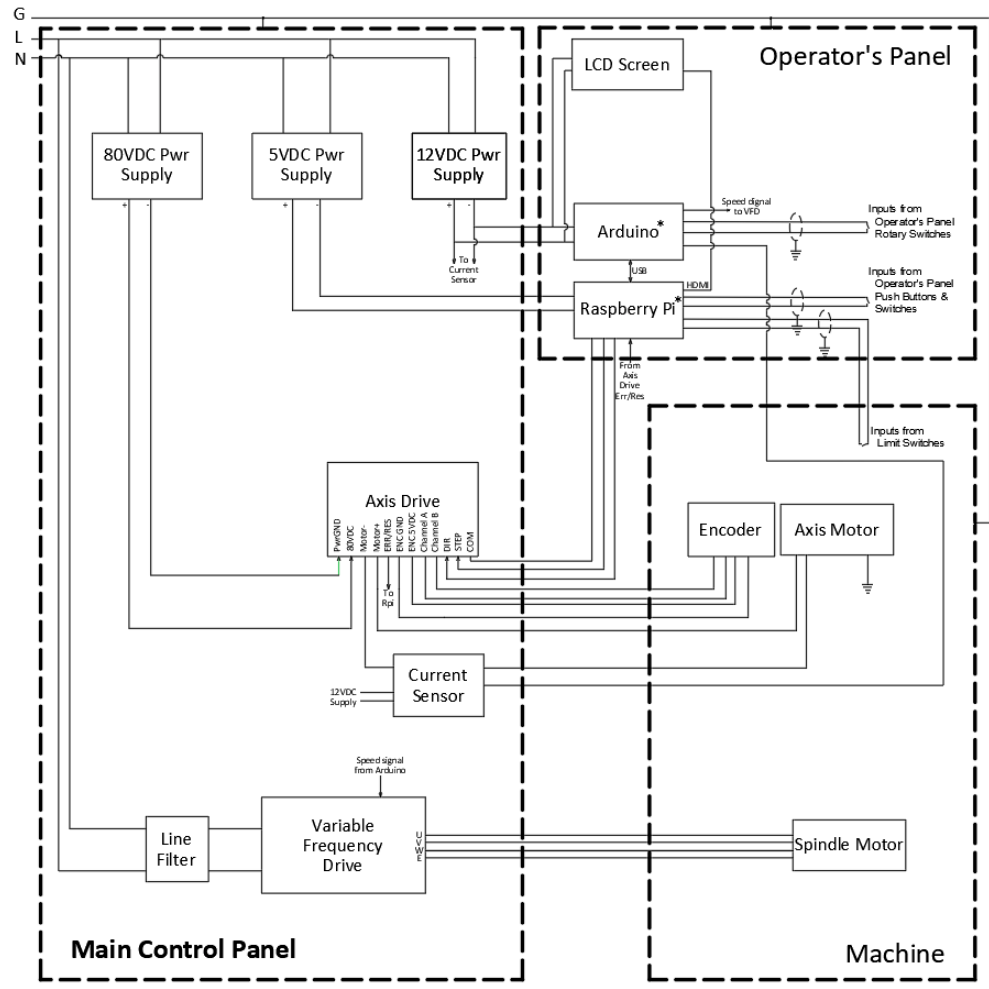
Figure 3. Electrical diagram of the CNC Machine. * Pinout details are given in Figures 4 and 5.